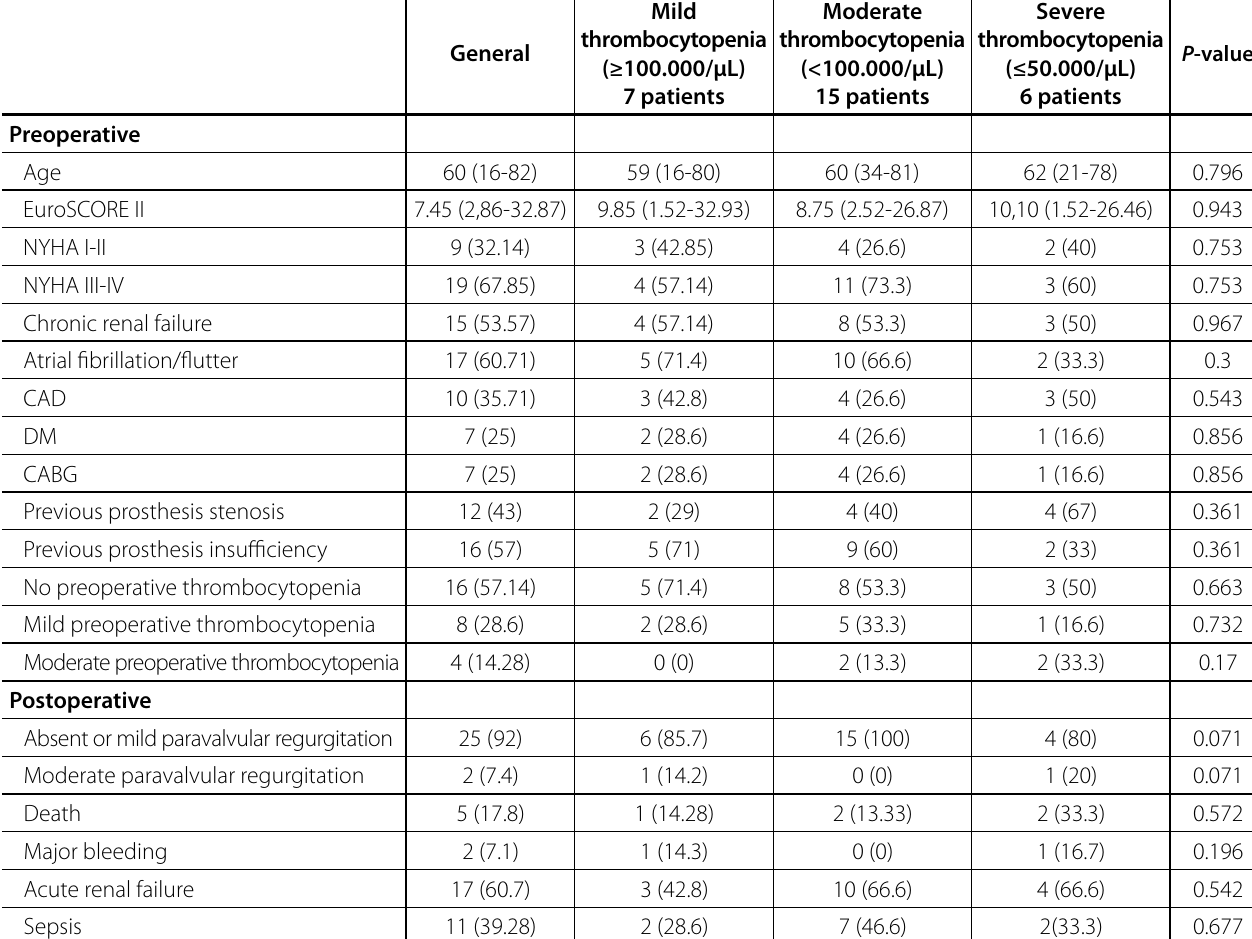
Table 1 . Baseline and postoperative characteristics of valve-in-valve patients according to the degree of thrombocytopenia, in absolute